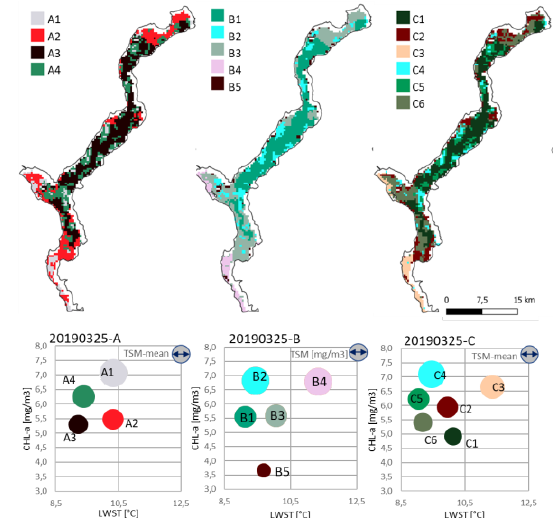
Figure 5 . Testing for number of clusters. Example with 4, 5 and 6 clusters applied on 2019-03-25-map for Lake Maggiore. Clusters are visualized with a RGB composition based on the three WQPs: Red is linked to LWST, Green to CHL-a, Blue to TSM clusters mean values, represented below in graphs. Here five clusters show to be the most suitable choice to significantly catch WQPs variability.